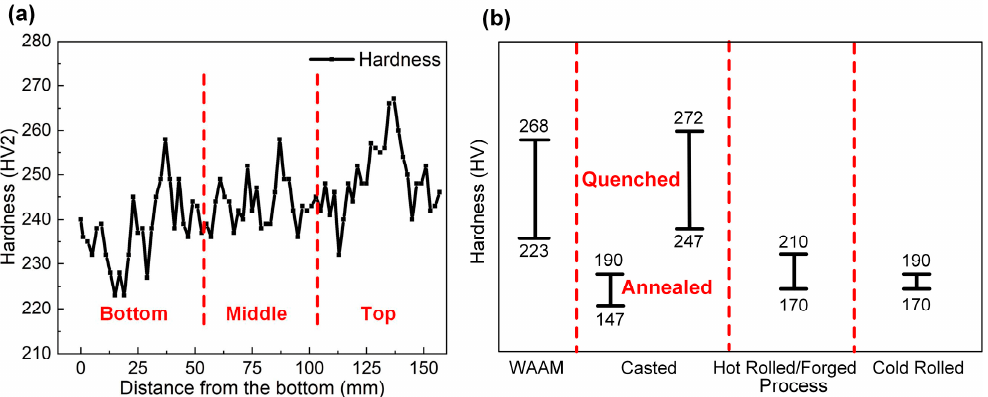
Figure 8. ( a ) Hardness of the XC-45 wall from the bottom to the top, ( b ) hardness comparison of different processes.